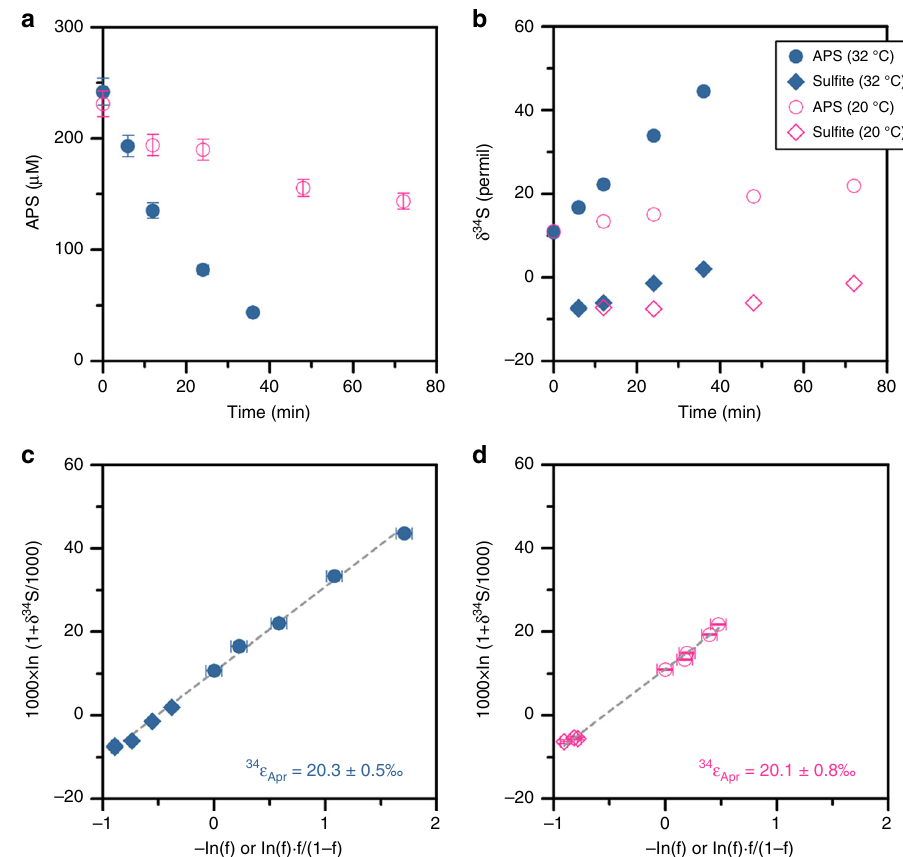
Fig. 2 Fractionation of sulfur isotopes during the enzymatic reduction of APS at 32 and 20 °C. a APS consumption by APS reductase as a function of time and temperature. b Evolution of the δ 34 S values of APS and sul fi te throughout the reaction at 32 °C ( c ) and 20 °C ( d ). Estimation of the kinetic sulfur isotope effect based on the Rayleigh distillation model. Values of 1000 ln(1 + δ 34 S(APS)/1000) and 1000 ln(1 + δ 34 S(Sul fi te)/1000) are plotted versus − ln( f ) and ln( f ) × f /(1 − f), respectively. Dashed lines represent the linear fi t, the slope of which was taken as a measure of the fractionation factor, 34 ε Analytical and propagated uncertainties are shown as error bars where